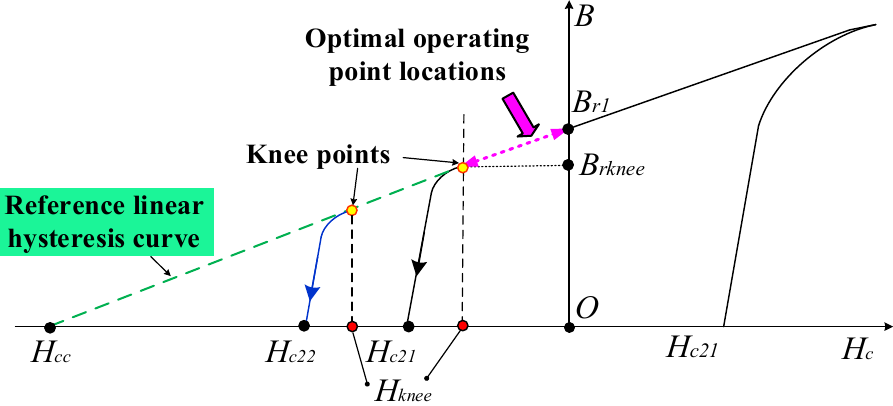
Figure 9. Virtual linear hysteresis curves of LCF PMs.